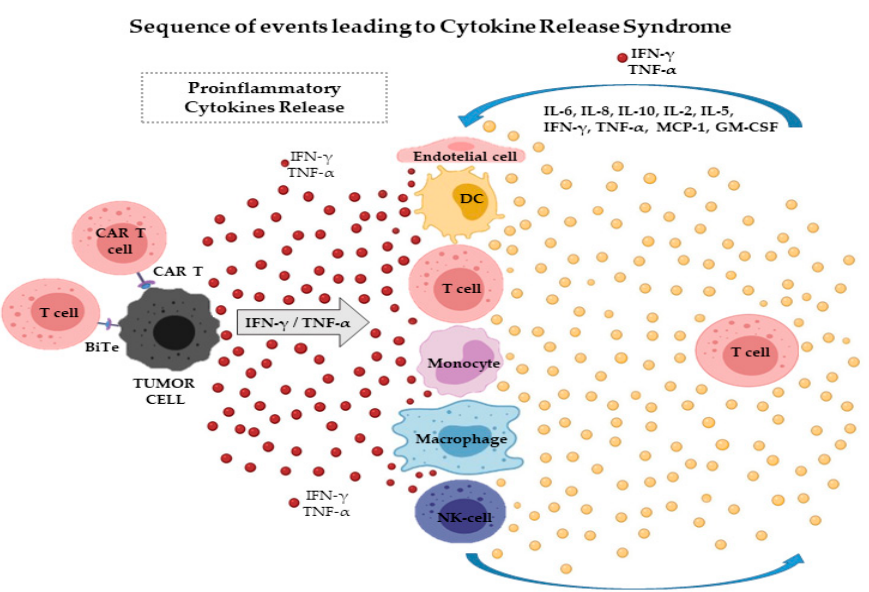
Figure 1. CAR T cells target tumor cells and induce the release of cytokines as IFN- γ or TNF- α , which lead to the activation of bystander immune and non-immune cells as monocytes/macrophages, dendritic cells, NK and T-cell, and endothelial cells. These cells further release proinflammatory cytokines triggering a cascade reaction. Macrophages and endothelial cells produce large amounts of IL-6 which in turn activates T cells and other immune cells leading to a cytokine storm. BiTe: bispecific T-cell engager; CAR: chimeric antigen receptor; IFN- γ : interferon-gamma; TNF- α : tumor necrosis factor-alpha; IL: interleukin; GM-CSF: granulocyte colony-stimulating factor; MCP-1: monocyte chemoattractant protein; NK cell: natural killer cell; DC: dendritic cell.